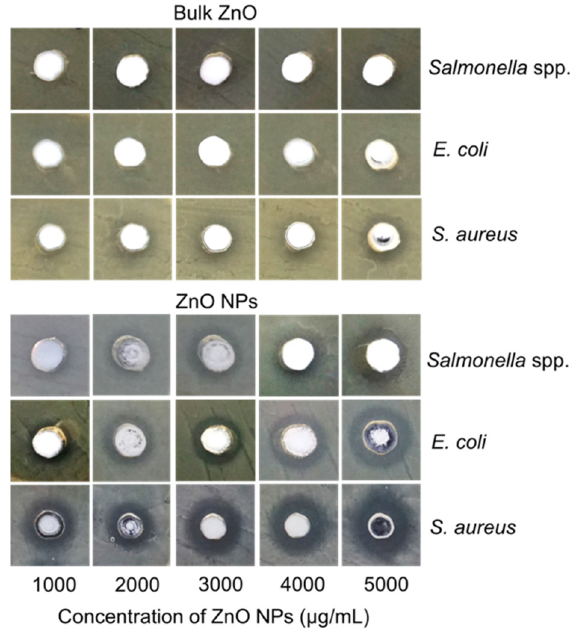
a–d Mean values with different superscripts in the same column corresponding to each type of bacteria are considered statistically different ( p < 0.05). x,y Mean value with different superscripts in the same row corresponding to different concentrations of ZnO NPs are considered statistically different ( p < 0.05). Values are mean ± SD error of three replicates. ND = No diameter for inhibition zone.